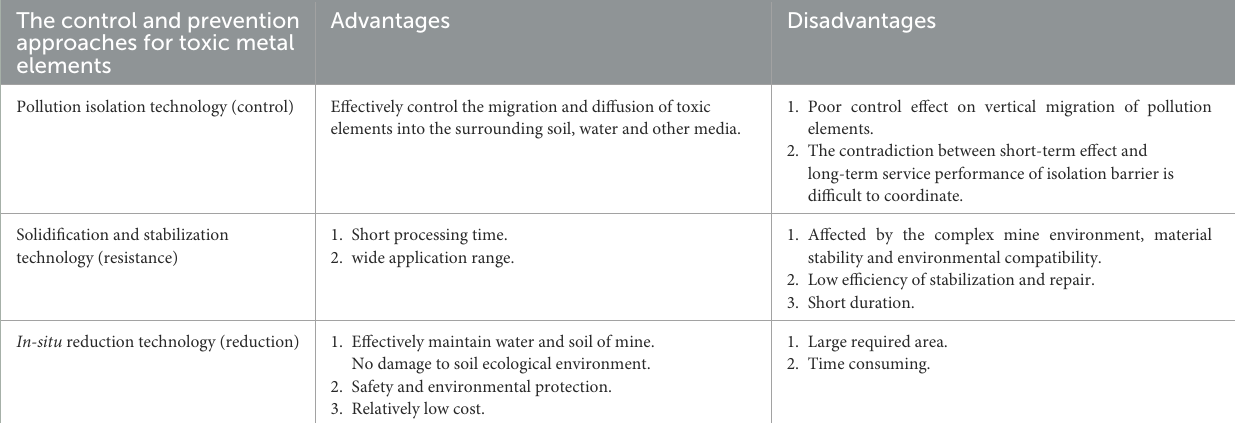
TABLE 2 Control and prevention approaches for toxic metal